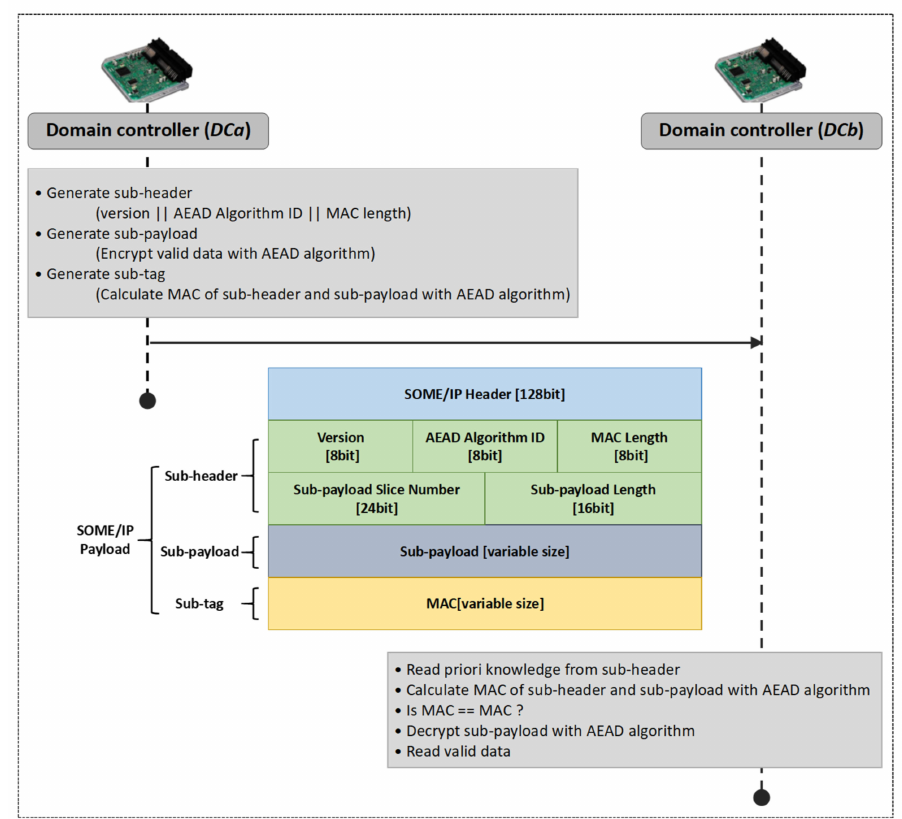
Figure 6. Proposed secure communication